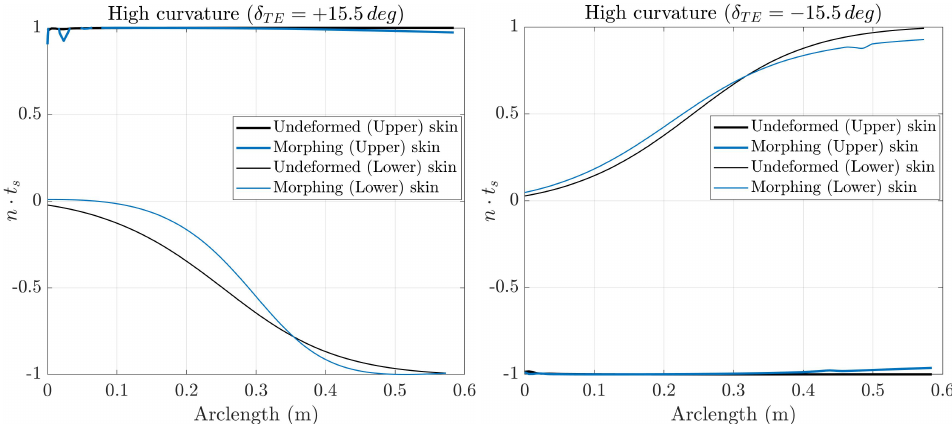
Figure 9. The directional cosines of the morphing skin deformation for optimal downward and upward